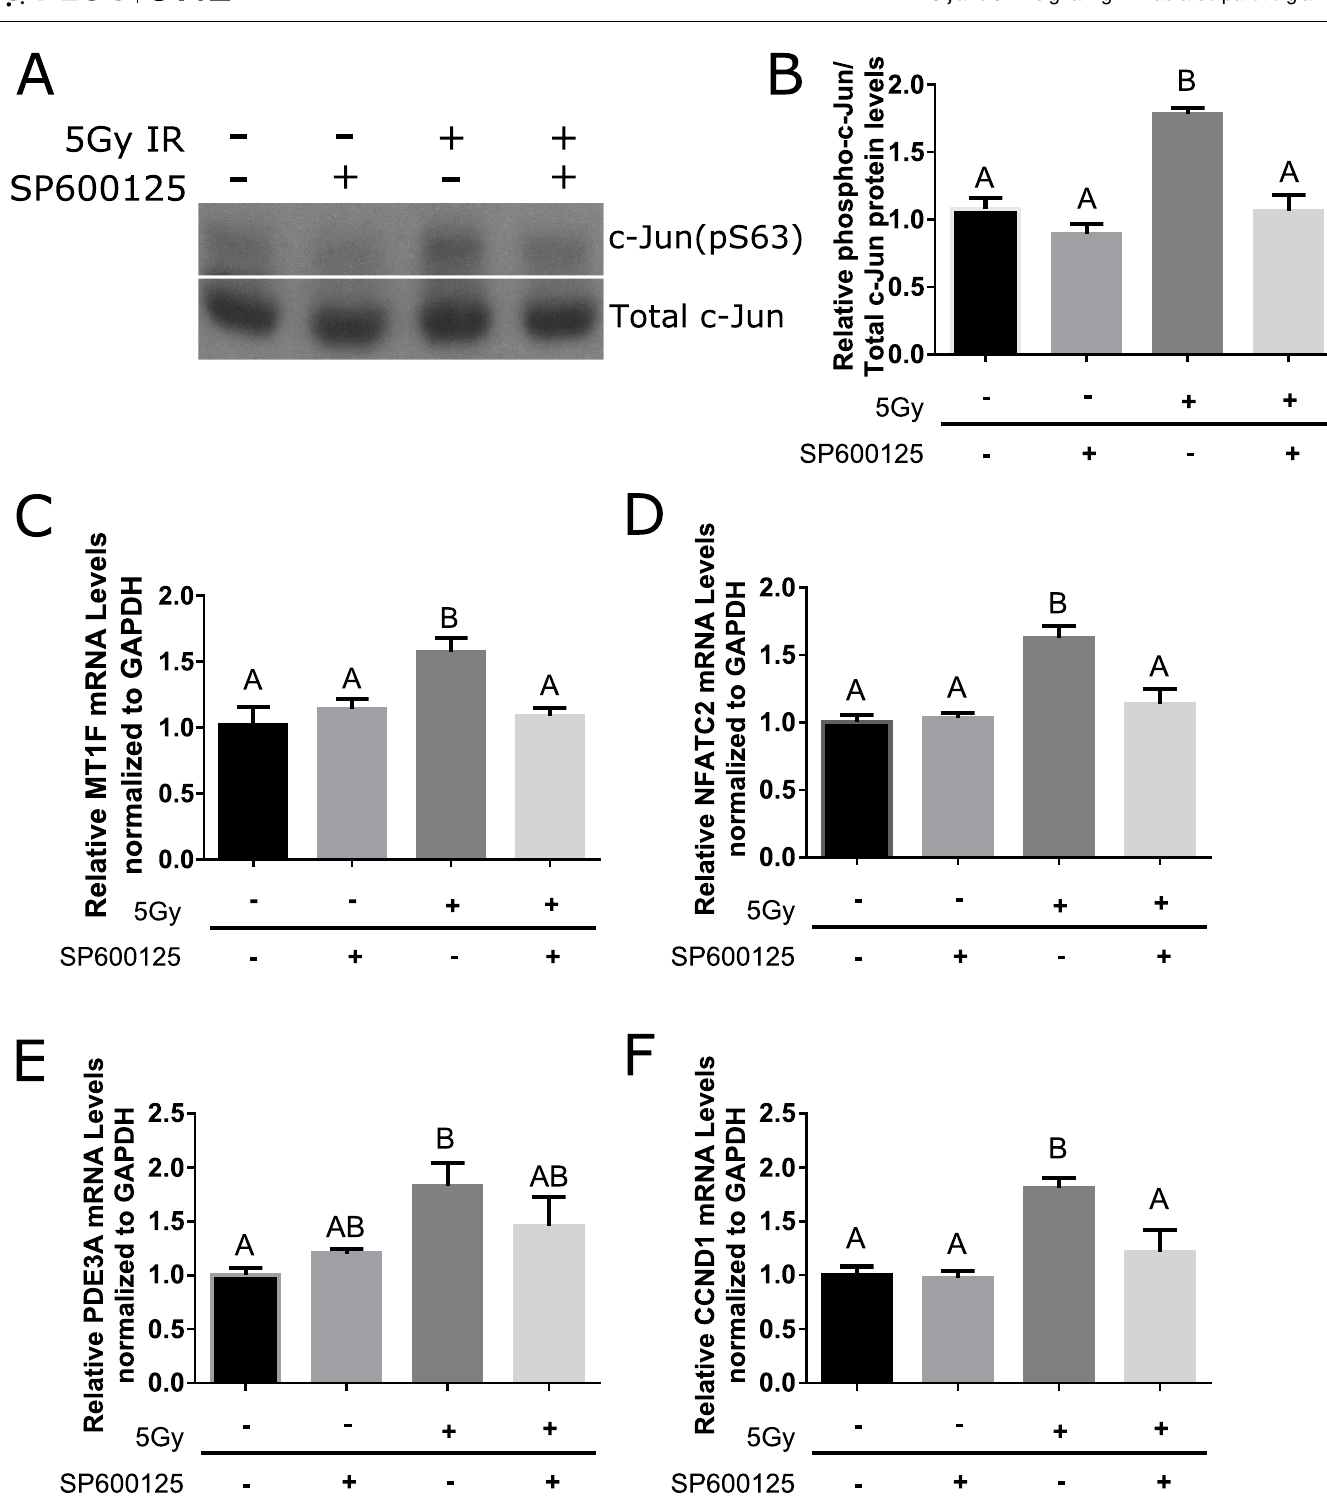
Fig 4. Inhibition of JNK signaling with SP600125 in irradiated cells. Parotid salivary glands from FVB mice were dissected and cultured as primary cell cultures. One day after dissection, the primary cells were irradiated with 5Gy and cell lysates or RNA were collected on Day 5 after radiation treatment. On Day 4 after radiation treatment, the cells were either treated with 10 μ M SP600125 or DMSO vehicle control. (A) Effects of SP600125 treatment on phosphorylated c-Jun (S63) in primary salivary cells were evaluated by immunoblotting. Blots were reprobed for total levels of c-Jun as a loading control. (B) Quantification by densitometry of A normalized to DMSO vehicle control. (C-F) Relative MT1F, PDE3A, NFATC2, and CCND1 mRNA levels determined by RT-PCR and normalized to GAPDH. Results are presented from at least three independent primary cell preparations; error bars denote mean ± SEM. Significant difference ( < 0.05) was determined by a Tukey-Kramer test for multiple comparisons. Treatment groups with different letters above the bar graphs are significantly different from each other.